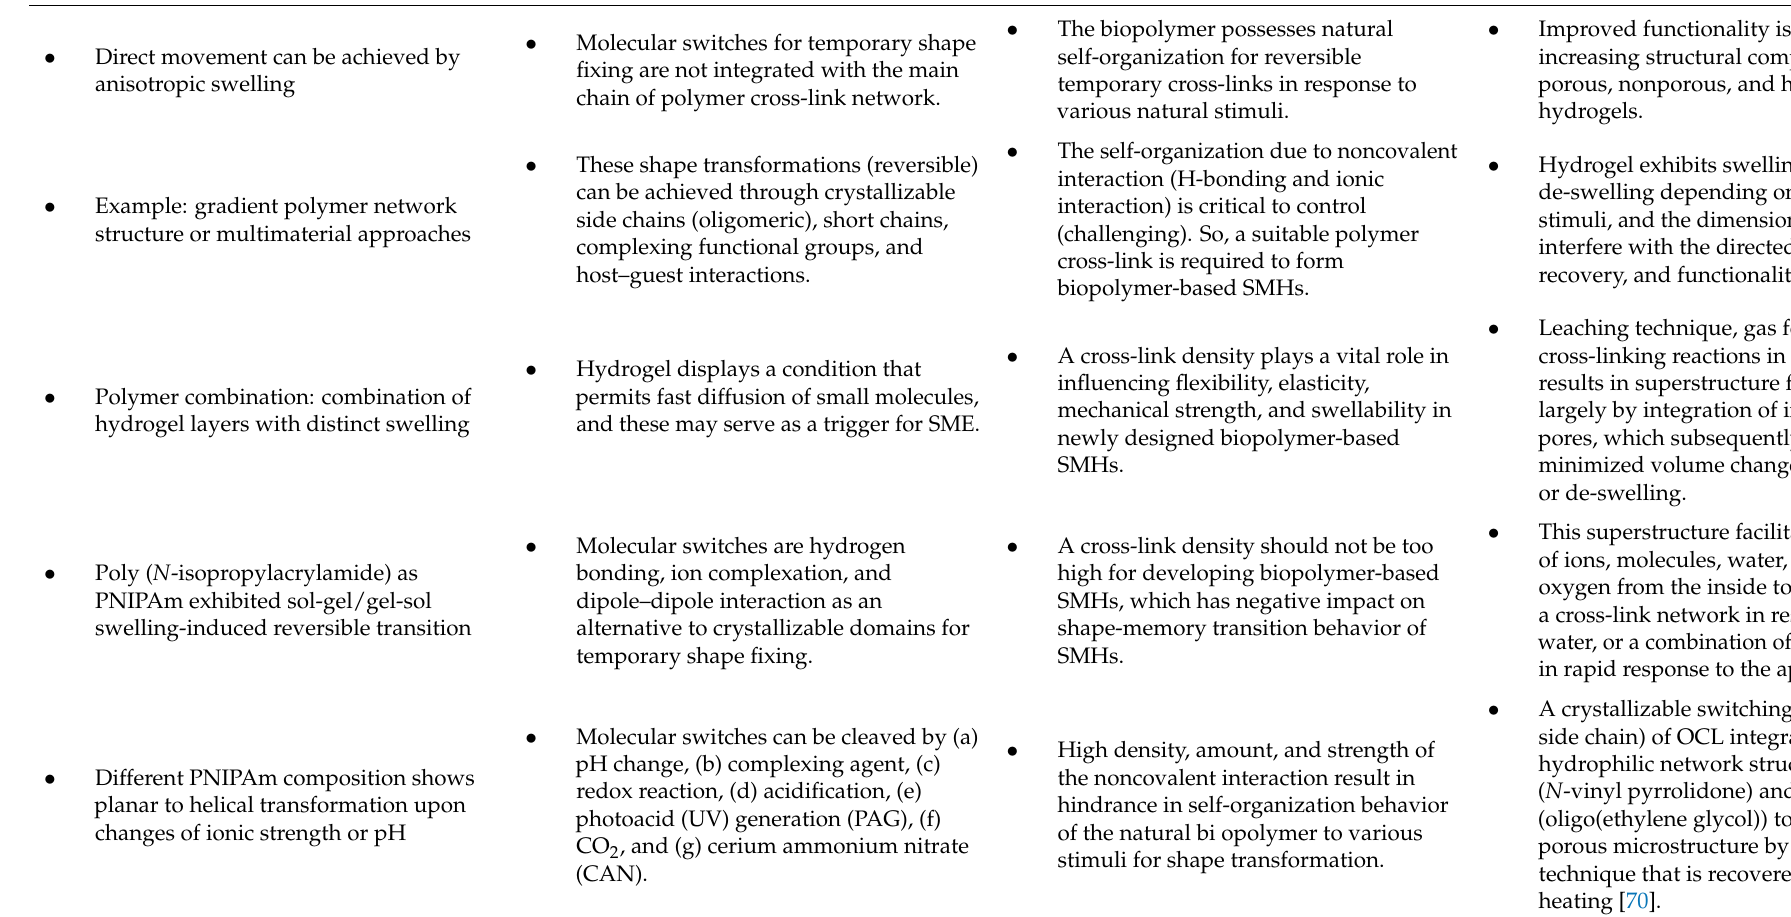
Table 2. Description of various types of shape-memory effects (SMEs), molecular switching for temporary shape fixations, and cleaving agents in hydrogels. Swelling-Induced